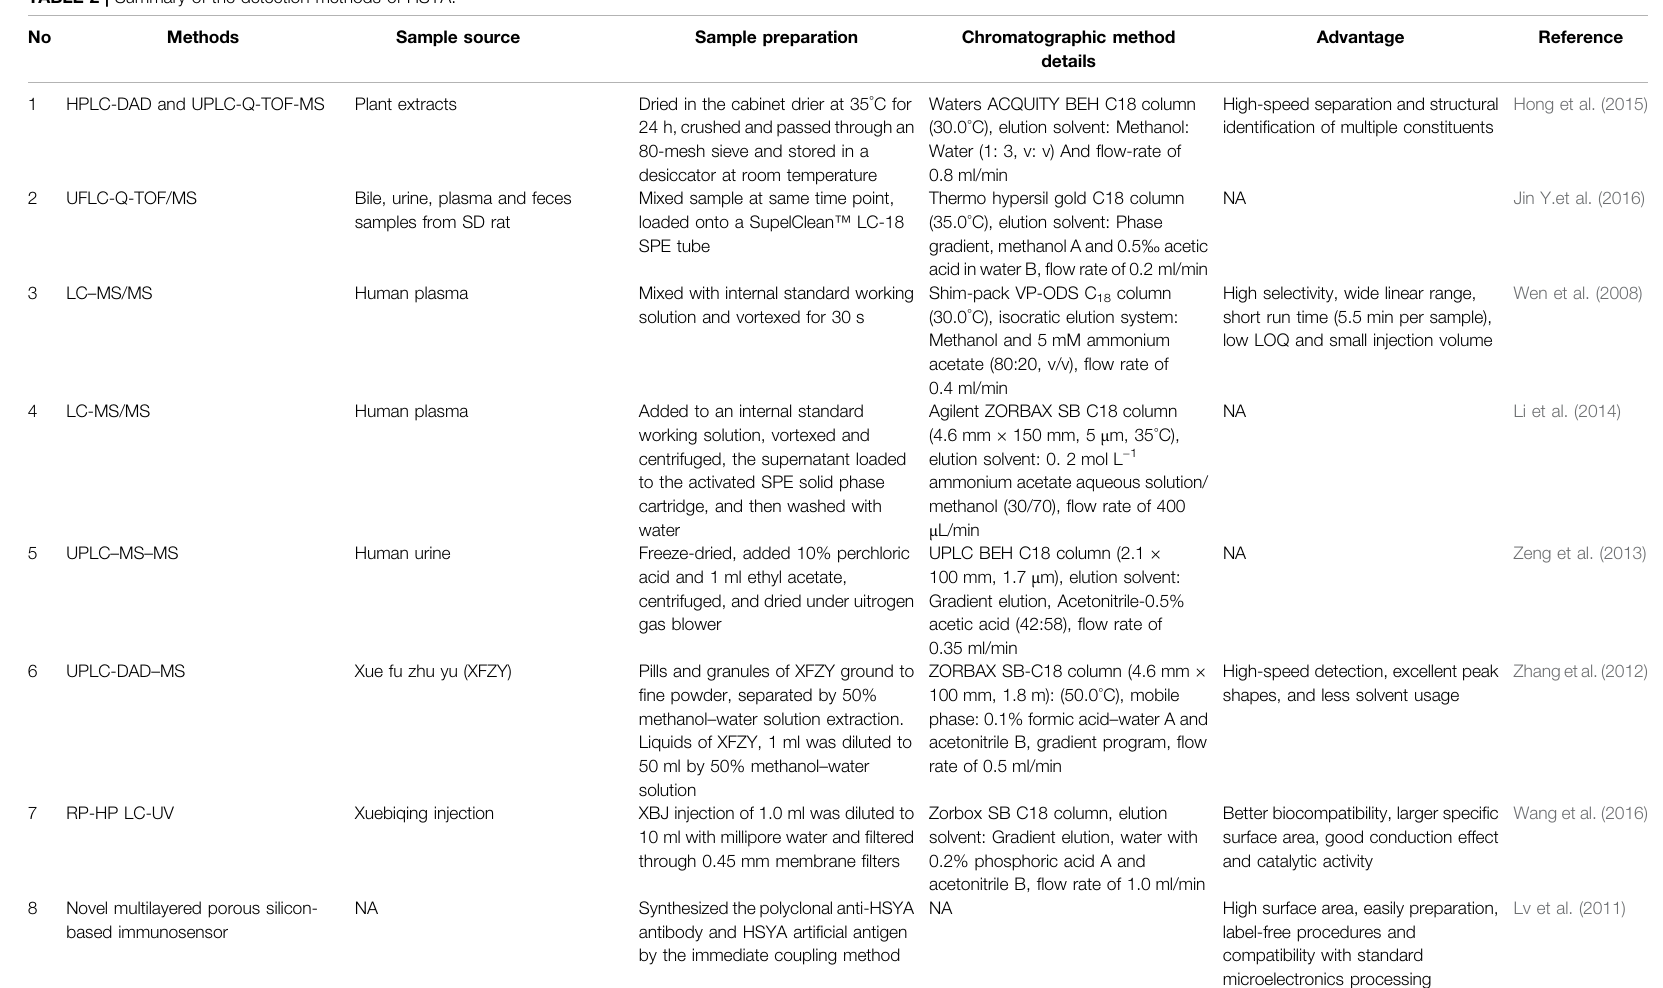
TABLE 2 | Summary of the detection methods of